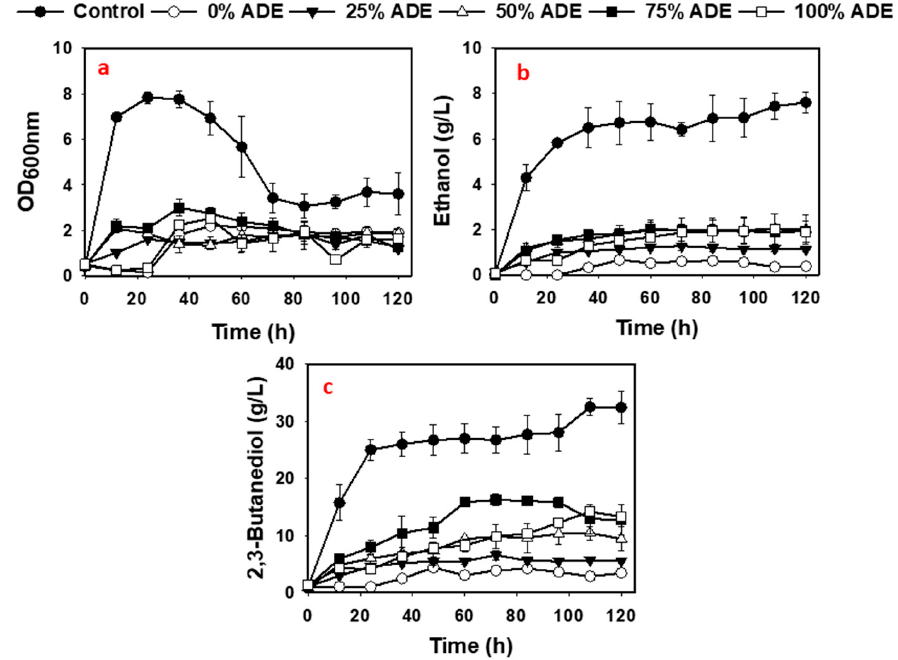
Figure 1. Fermentation profiles of 0–100% ( v / v ) ADE cultures of P. polymyxa ( a – c ) .